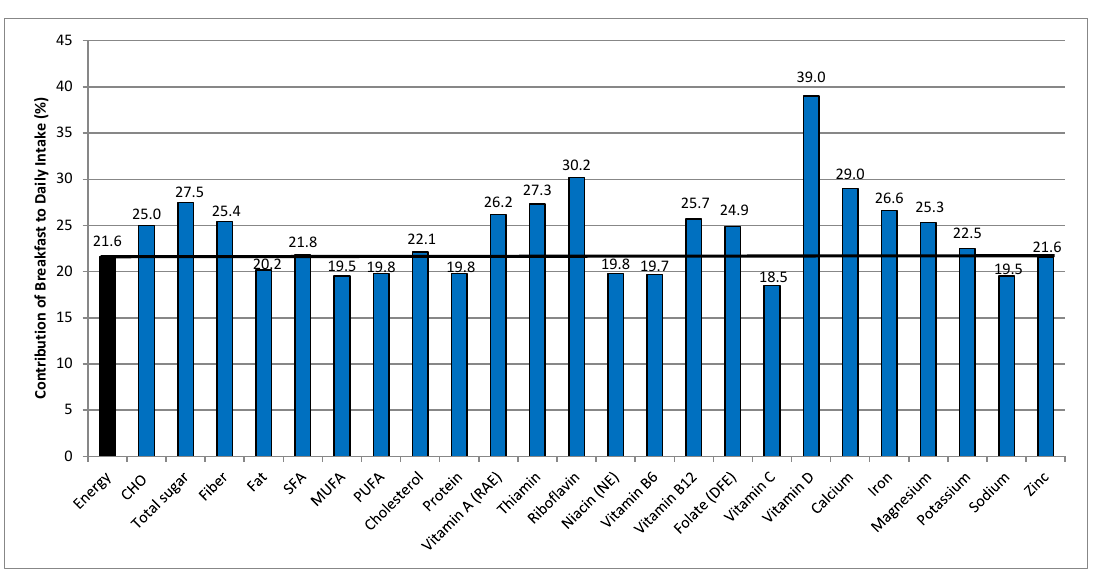
Figure 1. Contribution of nutrient intakes at breakfast to total daily nutrient intakes of Canadian breakfast consumers aged 6 years and above ( n = 16,484). The horizontal line is the percent of daily energy intake consumed at breakfast. CHO: carbohydrate; DFE: dietary folate equivalents; MUFA: monounsaturated fatty acids; NE: niacin equivalents; PUFA: polyunsaturated fatty acids; and RAE: retinol activity